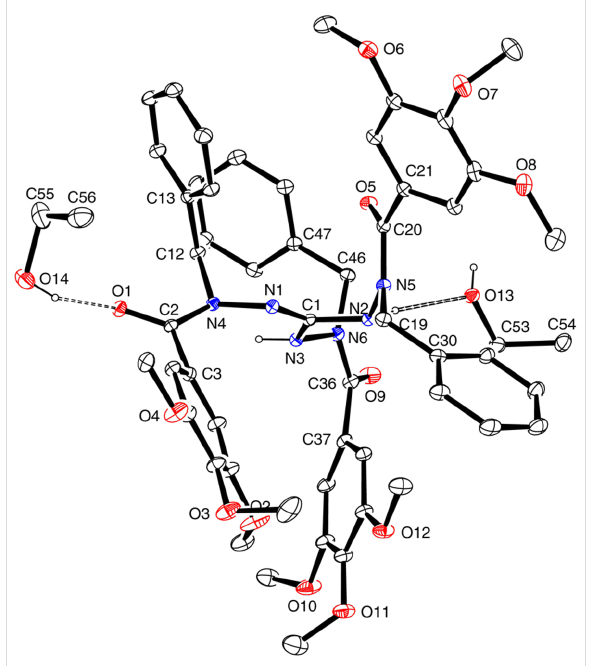
Figure 1: Molecular structure of 6b ·2C 2 H 5 OH in the solid state, with numbering of atoms (ORTEP plot). Selected bond lengths (Å): C1–N1 1.297(4), C1–C2 1.390(4), C1–N3 1.365(4). Selected bond angles (°): N1–C1–N2 117.3(3), N2–C1–N3 115.6(2), N1–C1–N3